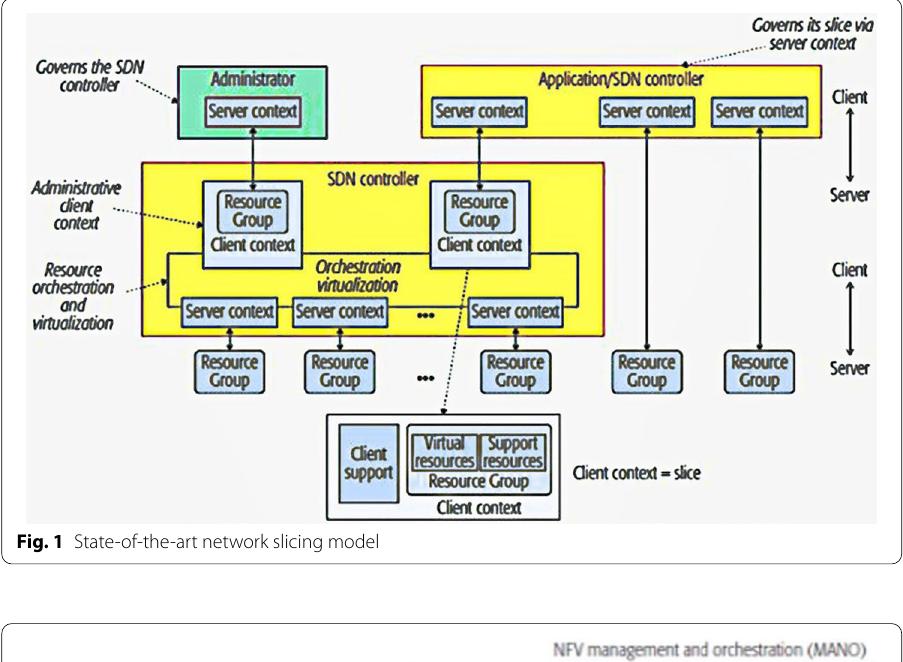
Fig. 1 State-of-the-art network slicing model